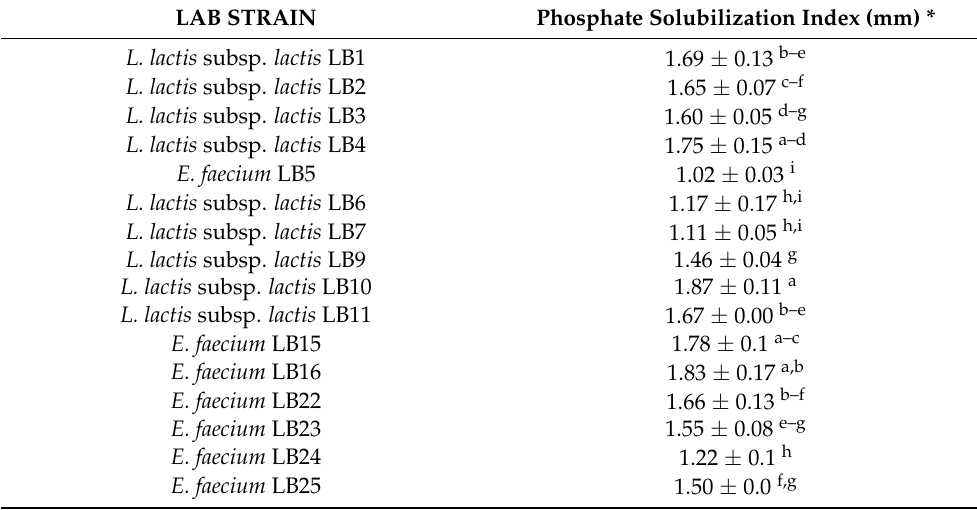
Table 2. Values of phosphate solubilization index measured for LAB strains isolated from wheat rhizospheric soil